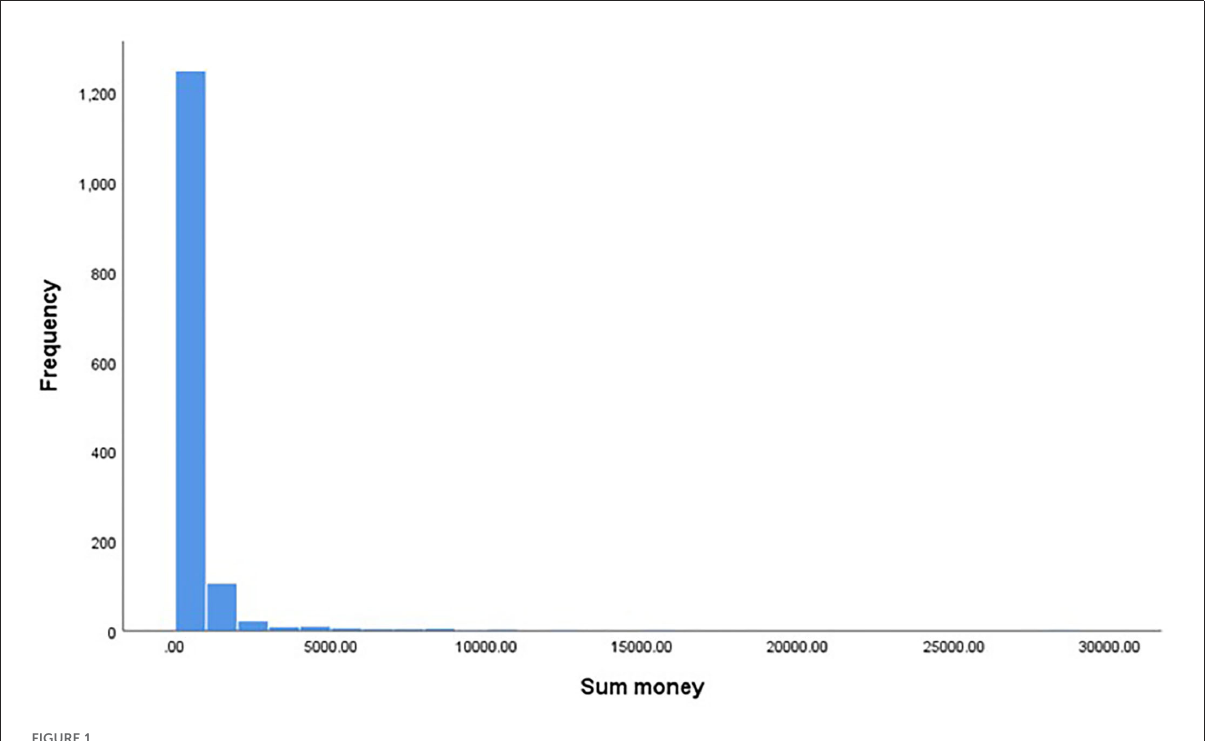
FIGURE1 Frequency distribution of total bet